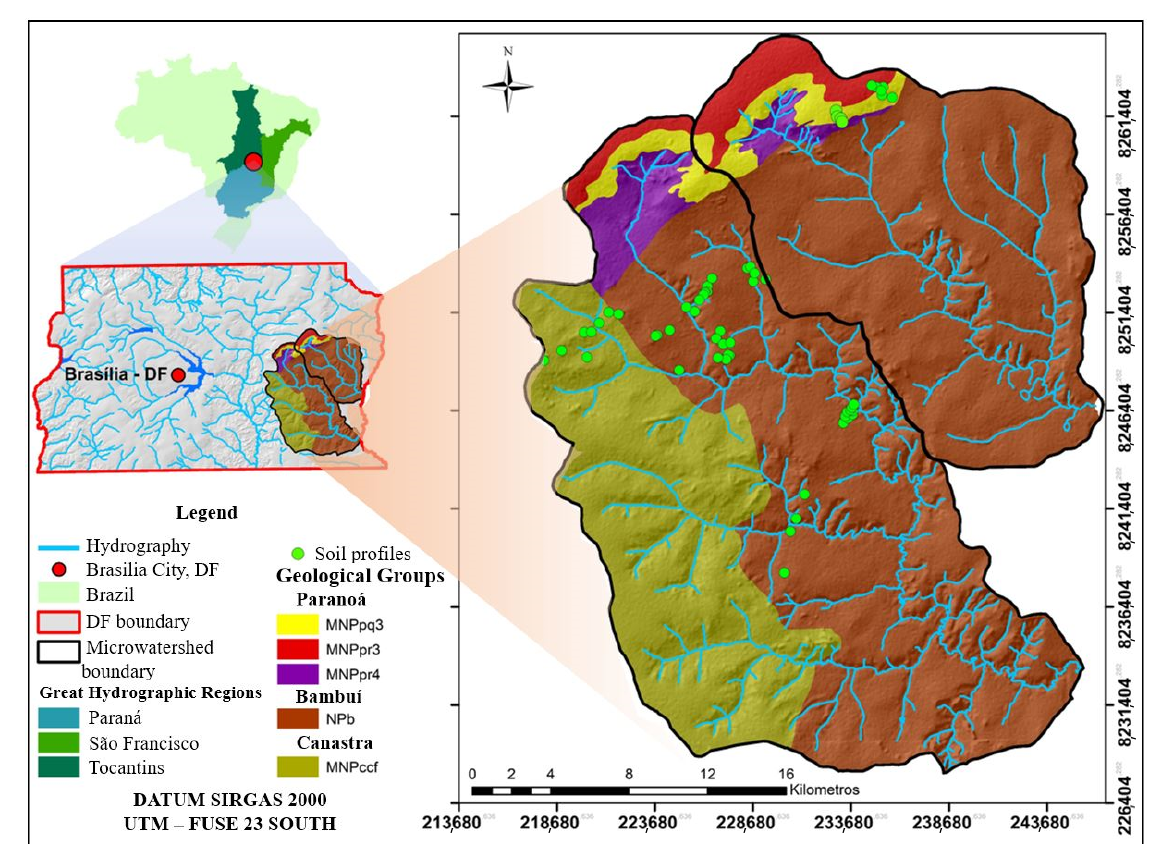
Figure 1. Location map of Rio Jardim (RJ–source area) and Ribeirão Extrema (RE–target area), The green light dots represent the soil profile sampled spots. both overlaid with local geology, according to Freitas ‐ Silva and Campos (1998) [20]. MNP: Mesoneoproterozoic age rocks (units: pq3–quartizite; pr3–rithmite; pr4–clay rithmite; b–bambuí; ccf–canastra).